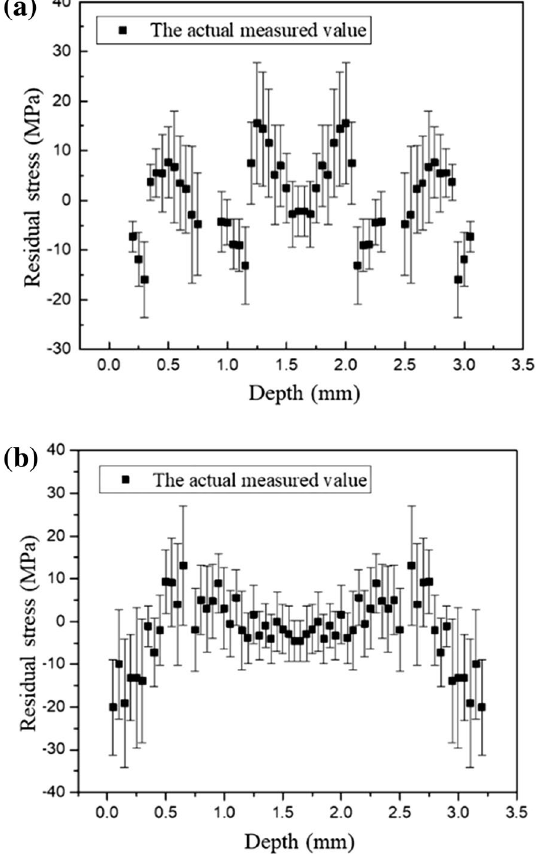
Figure 3 Initial residual stress thickness direction distribution in pure copper thin substrate: ( a ) Y direction, ( b ) X